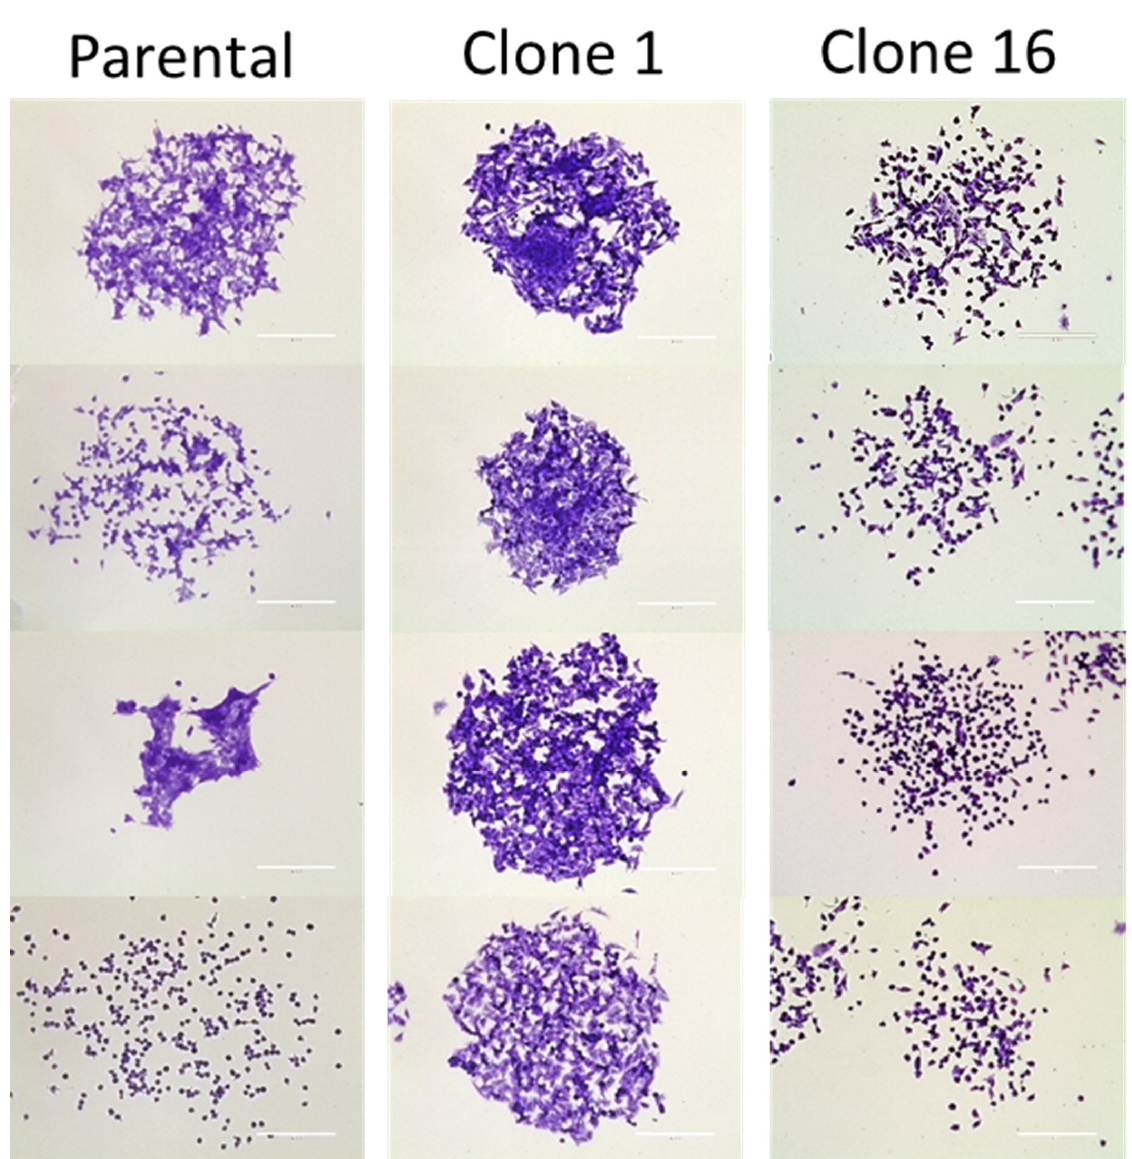
Figure 1. Clonogenic assay of 4T1 parental, clone 1, and clone 16 cells. In contrast, parental cells produced heterogeneous colonies, clone 1 and clone 16 cells produced clone-dependent similar colonies. Scale bar, 200 µm.